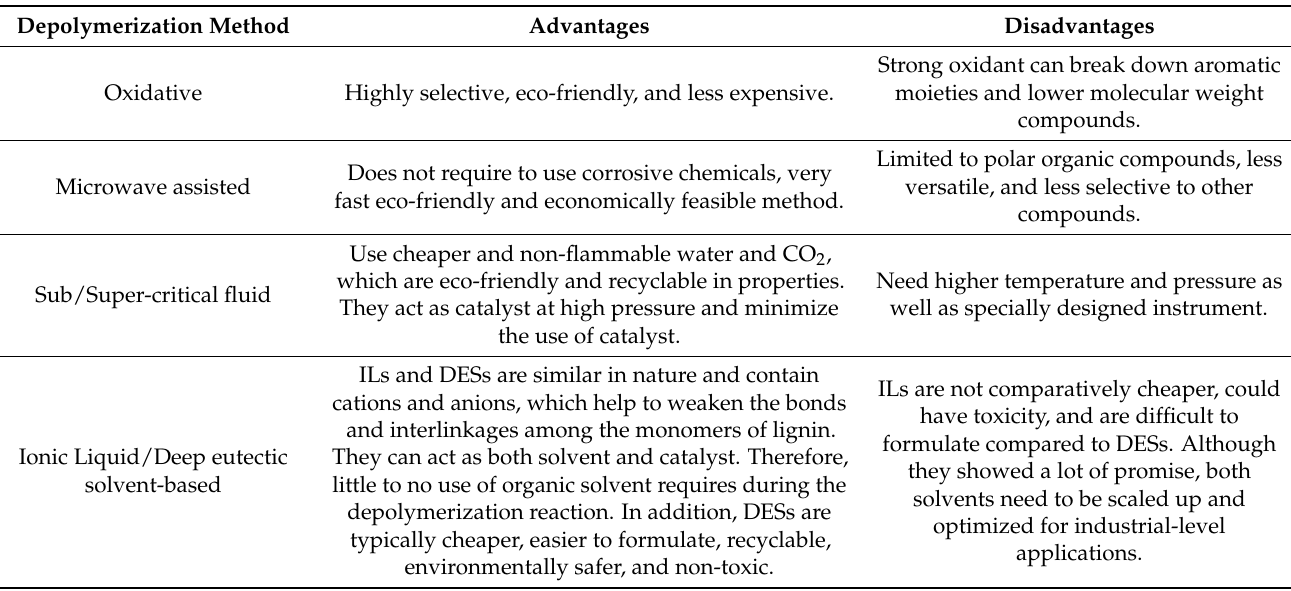
Table 9. Comparative advantages and disadvantages of greener depolymerization of